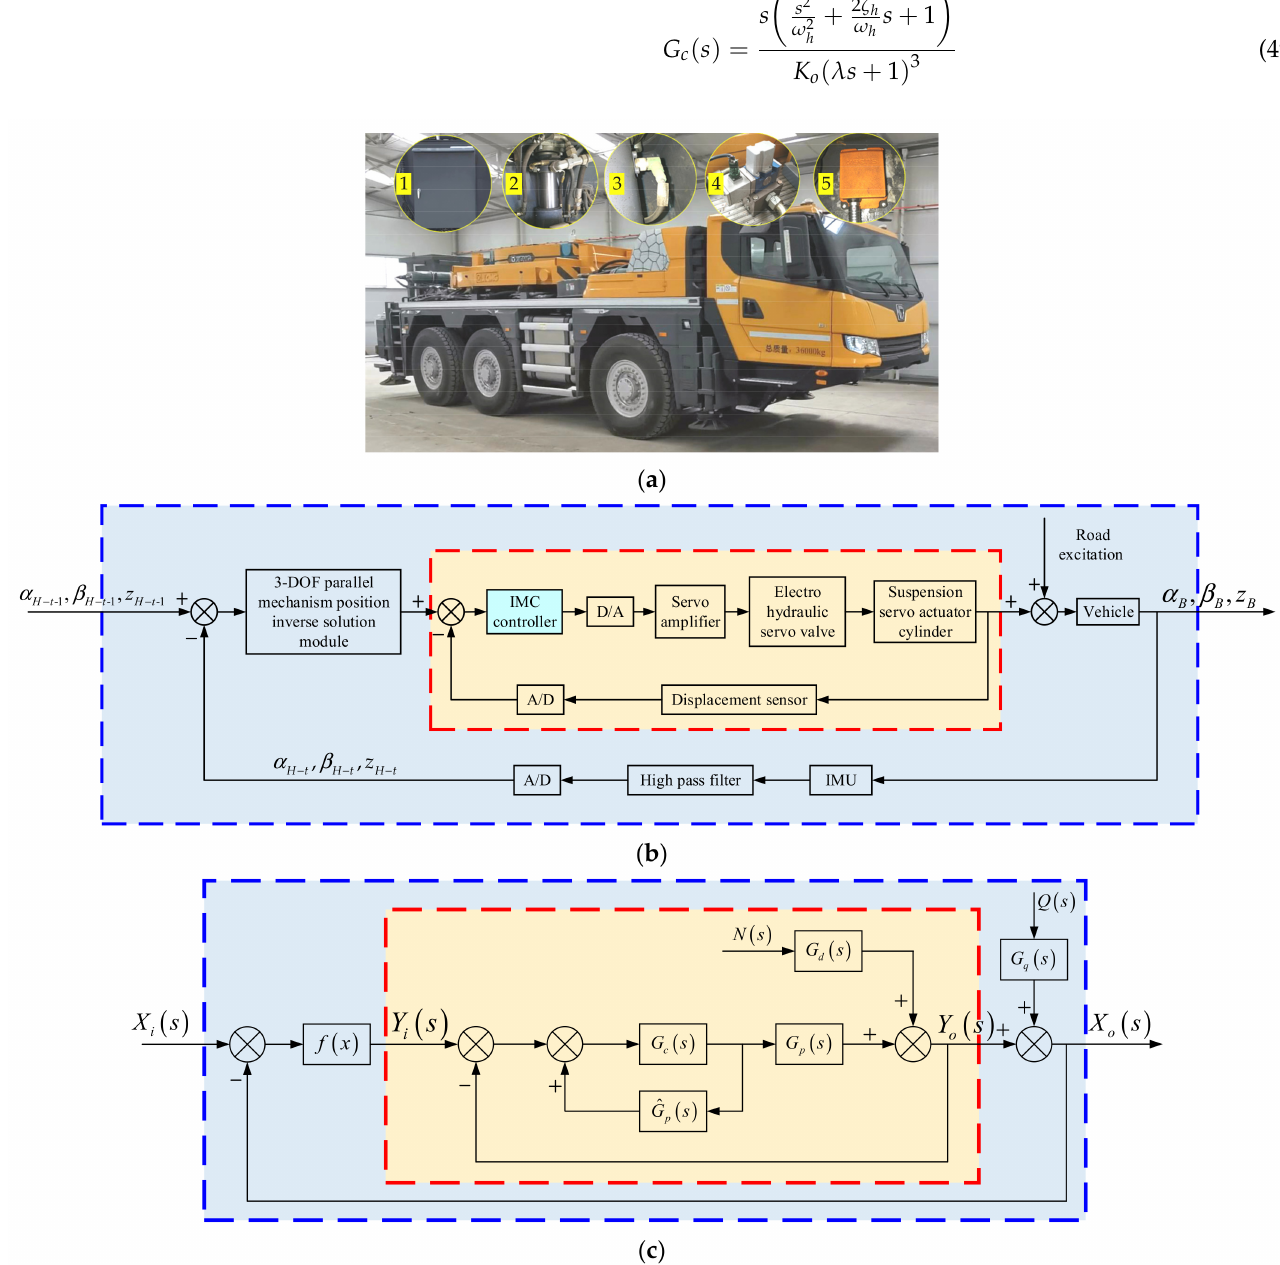
Figure 11. Vehicle experiment platform and schematic diagram of active suspension control system: ( a ) Vehicle experiment platform: (1) Electric control system. (2) Suspension servo actuator cylinder. (3) Displacement sensor. (4) Servo valve. (5) IMU; ( b ) Schematic diagram of active suspension control system; ( c ) Block diagram of active suspension control